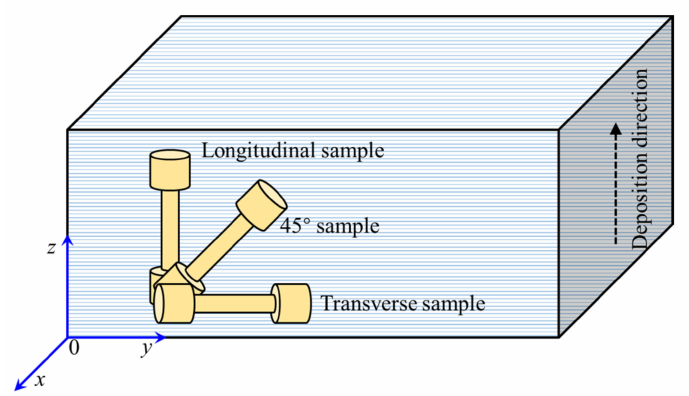
Figure 1. Tensile samples and sampling